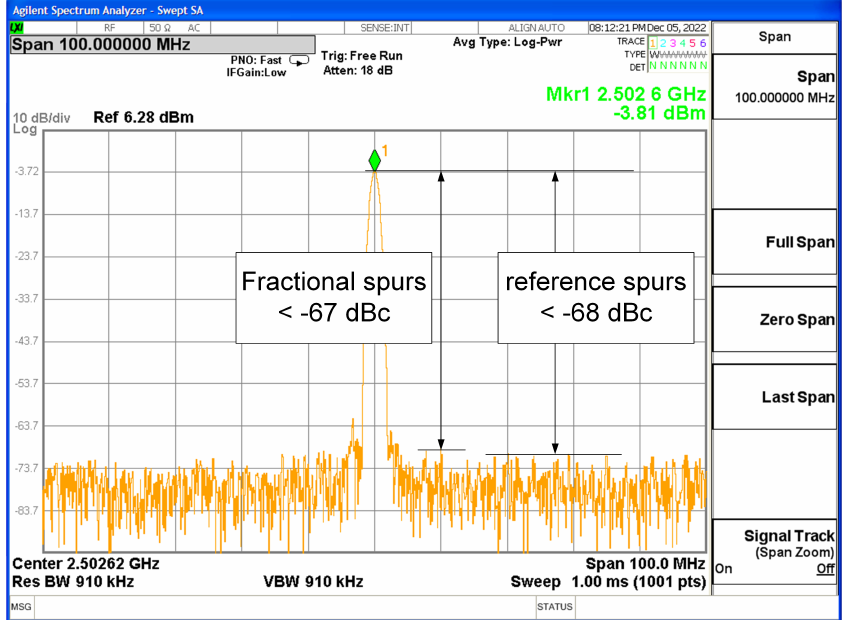
Figure 15. Spectrum of proposed FNPLL with phase interpolation on.